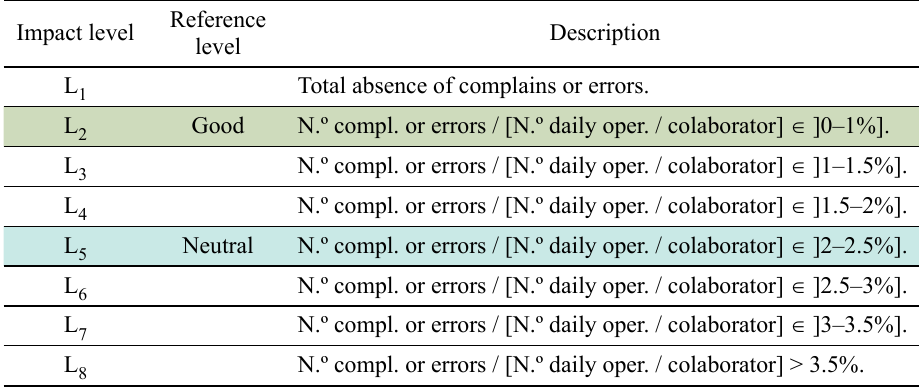
(human resources 2